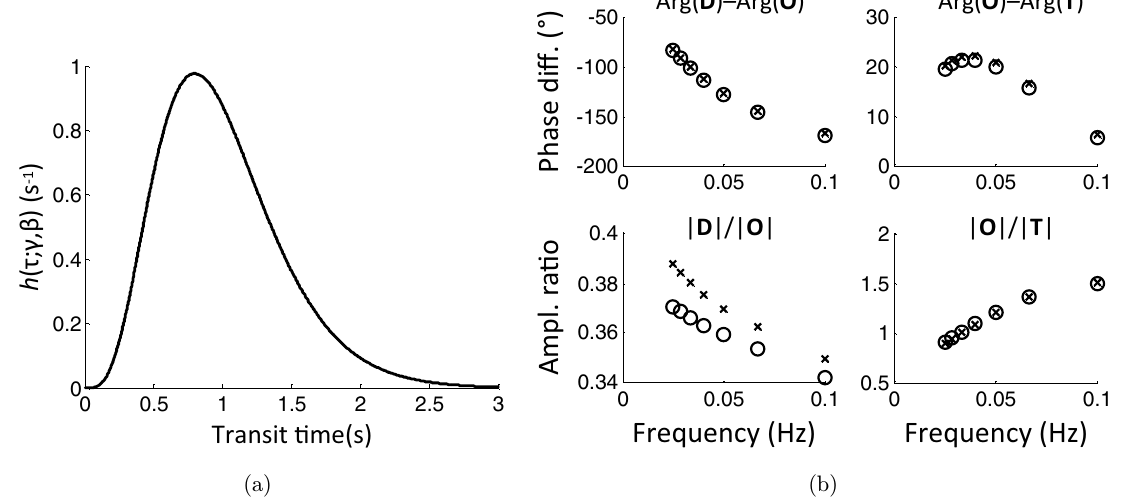
Fig. 1. (a) pdf of the capillary transit time ½ h ð (cid:2) ; (cid:3);(cid:4) Þ(cid:1) for (cid:3) ¼ 5 and (cid:4) ¼ 0 : 2 s, which yield h (cid:2) i ¼ 1 s and (cid:5) ð (cid:2) Þ (cid:5) 0 : 45 s. (b) CHS spectra of phase di®erences [Arg( D ) (cid:2) Arg( O ) and Arg( O ) (cid:2) Arg( T )] and amplitude ratios [ j D j = j O j and j O j = j T j ] as a function of the oscillation frequency. The crosses represent data obtained with the original model, whereas the empty circles represent data obtained with the extended